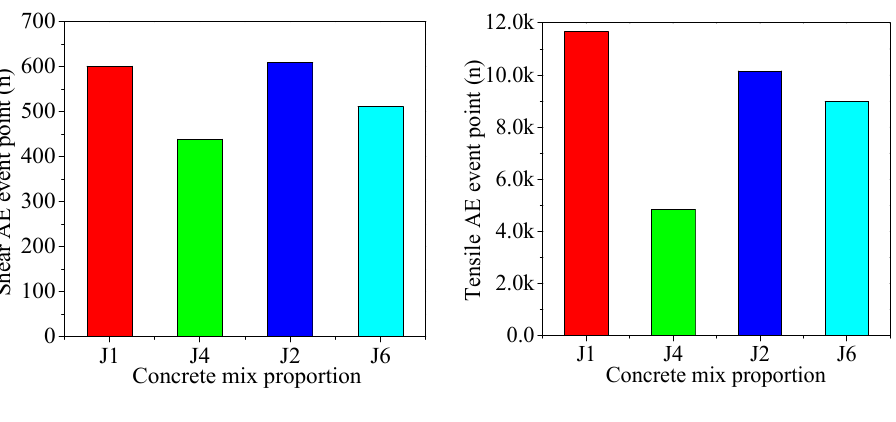
( b ) Influence of coarse aggregate on AE event point of concrete Figure 10. Influence of coarse and fine aggregate on AE event point of concrete. Figure 10. Influence of coarse and fine aggregate on AE event point of